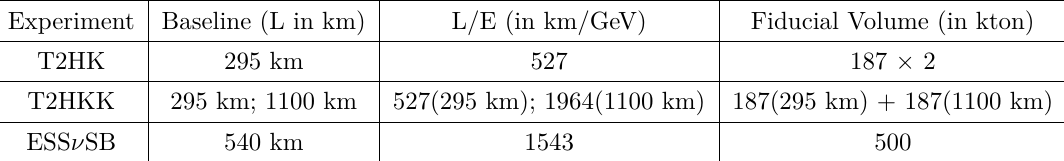
Table 1 . The baselines, L/E and fiducial volumes of each detector for T2HK(L1), T2HK(L2) and ESS ν SB. The energies for T2HK and ESS ν SB are 0.56 GeV and 0.35 GeV respectively.